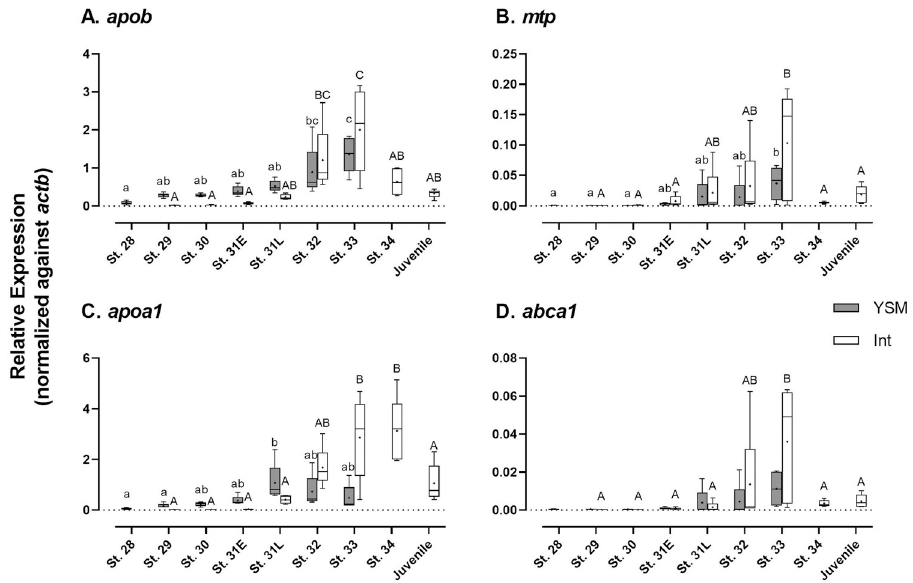
Fig 4. Developmental changes in gene expression involved in lipid absorption. (A) apob ; (B) mtp ; (C) apoa1 ; (D) abca1 . Data are presented using box and whisker diagrams of N = 5. Uppercase and lowercase letters indicate significant developmental differences in embryonic intestine and yolk sac membrane, respectively after one way ANOVA, Tukey’s test ( P <